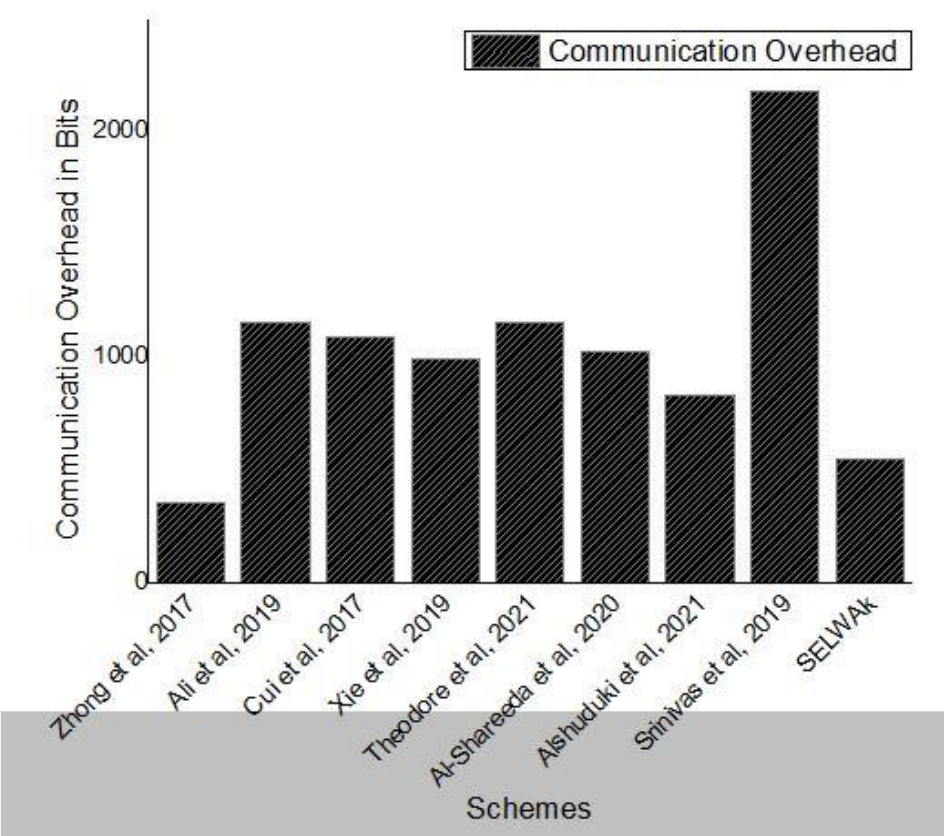
Figure 8. Communication Overhead Comparison.